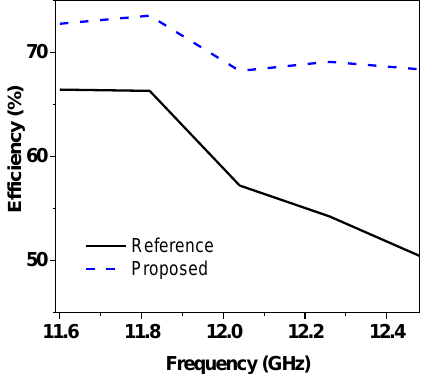
Figure 8. Measured total efficiency.